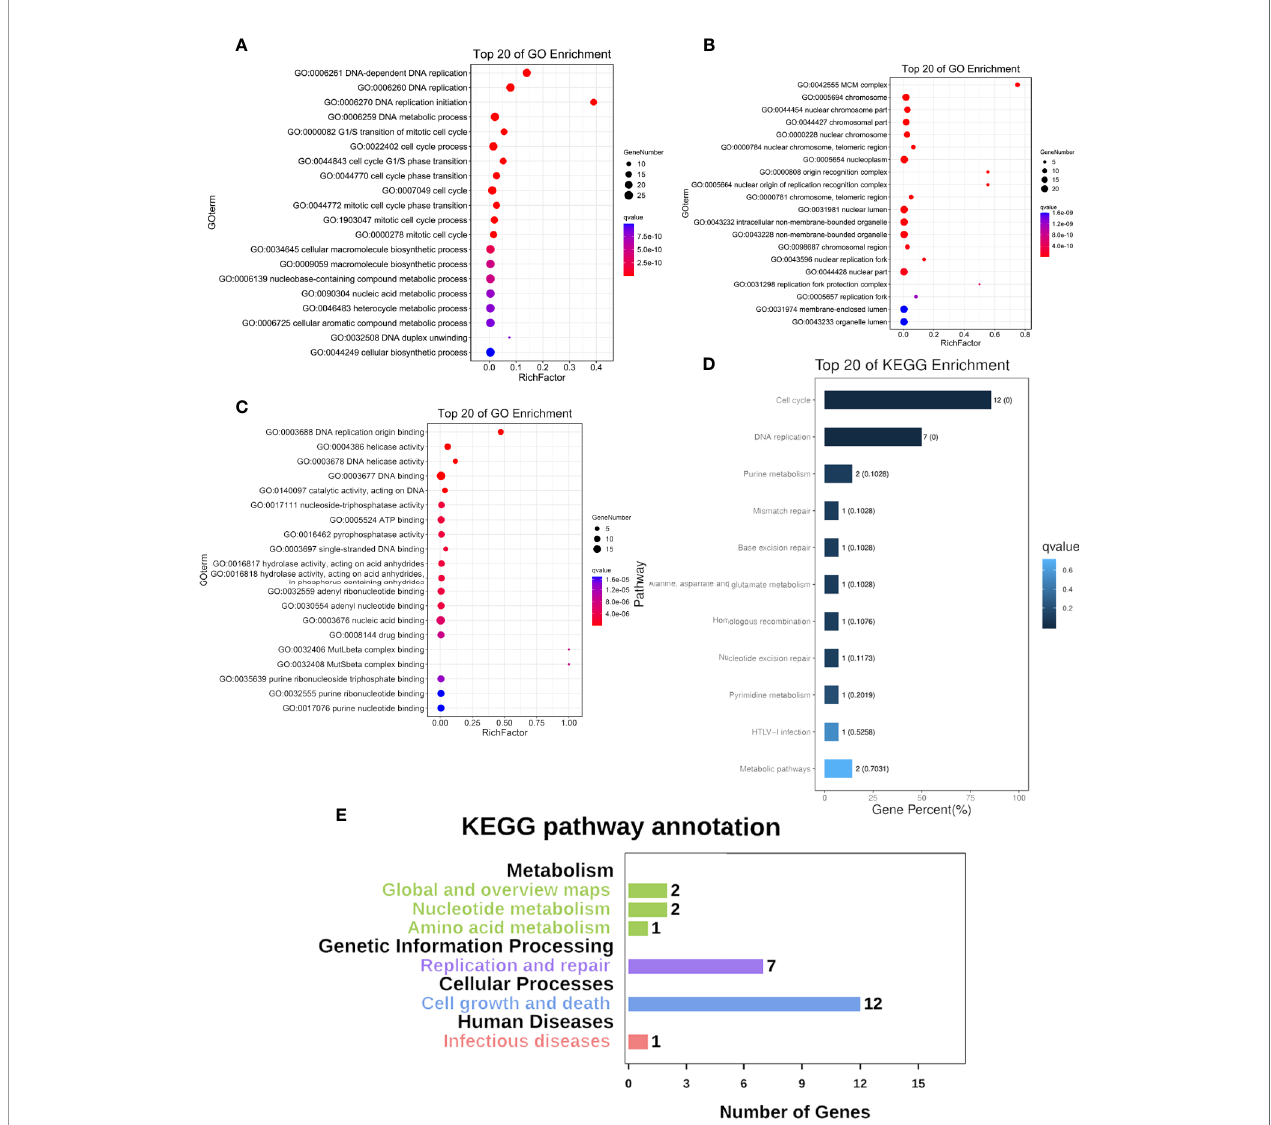
FIGURE 8 | Functional enrichment of the MCM complex and neighbouring interaction genes in OC patients. (A) Biological progression terms. (B) Cellular component terms. (C) Molecular function terms. (D) KEGG terms. (E) KEGG